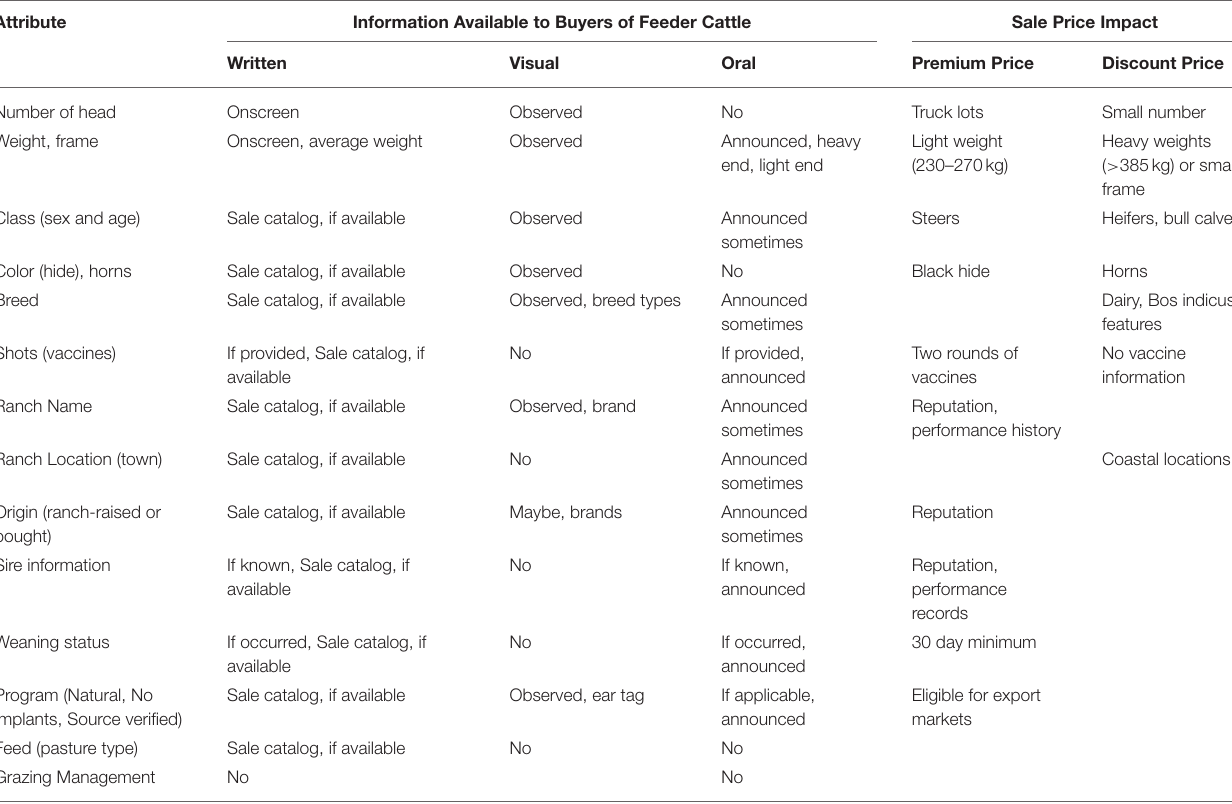
TABLE 3 | Information available to cattle buyers for feeder cattle from San Francisco Bay Area ranches and impact on sale